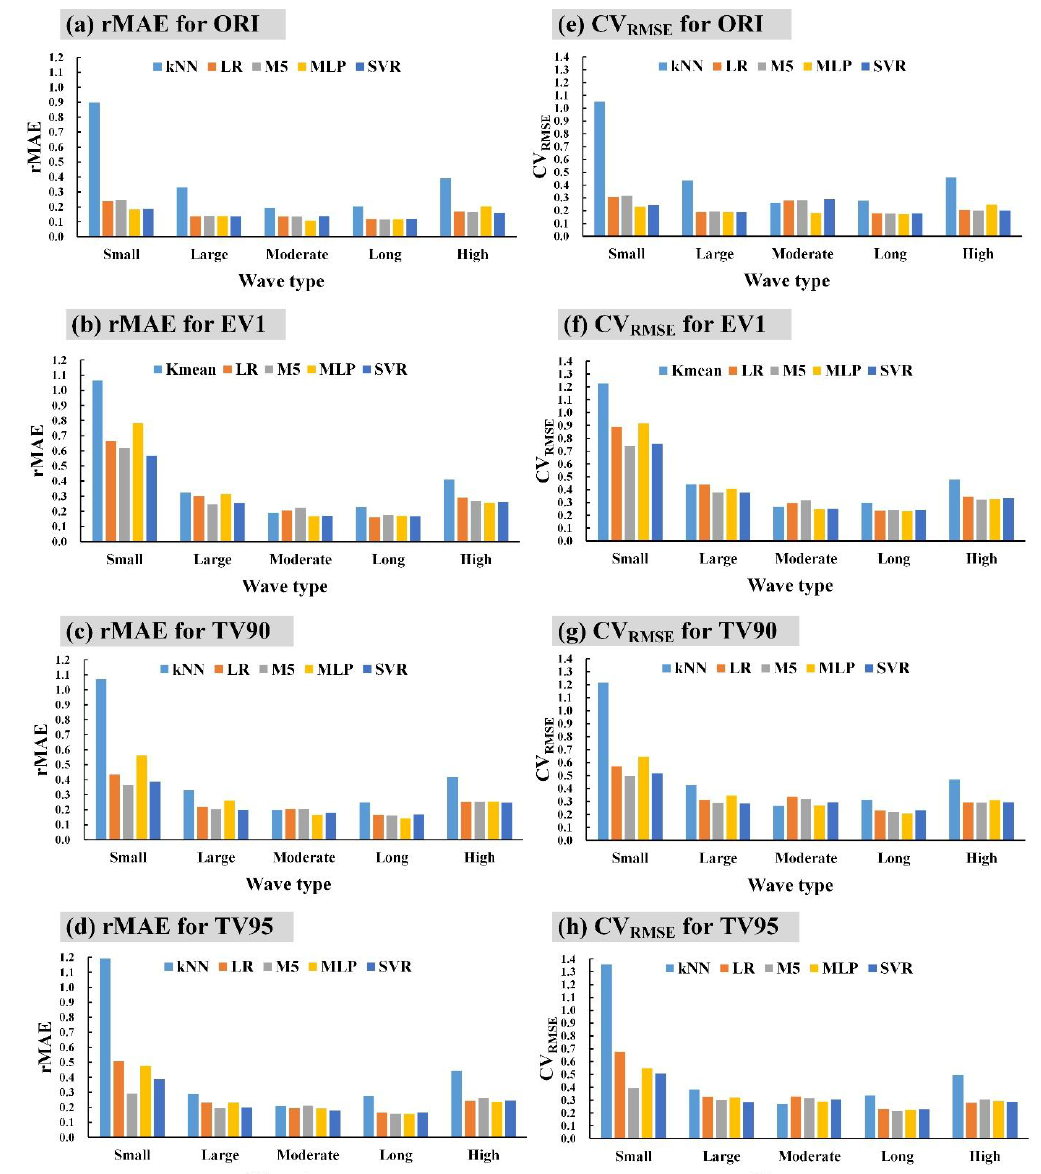
Figure 8. Performance measures of classified wave heights for the four PCA cases: ( a – d ) rMAE, and ( e – h ) CV RMSE .